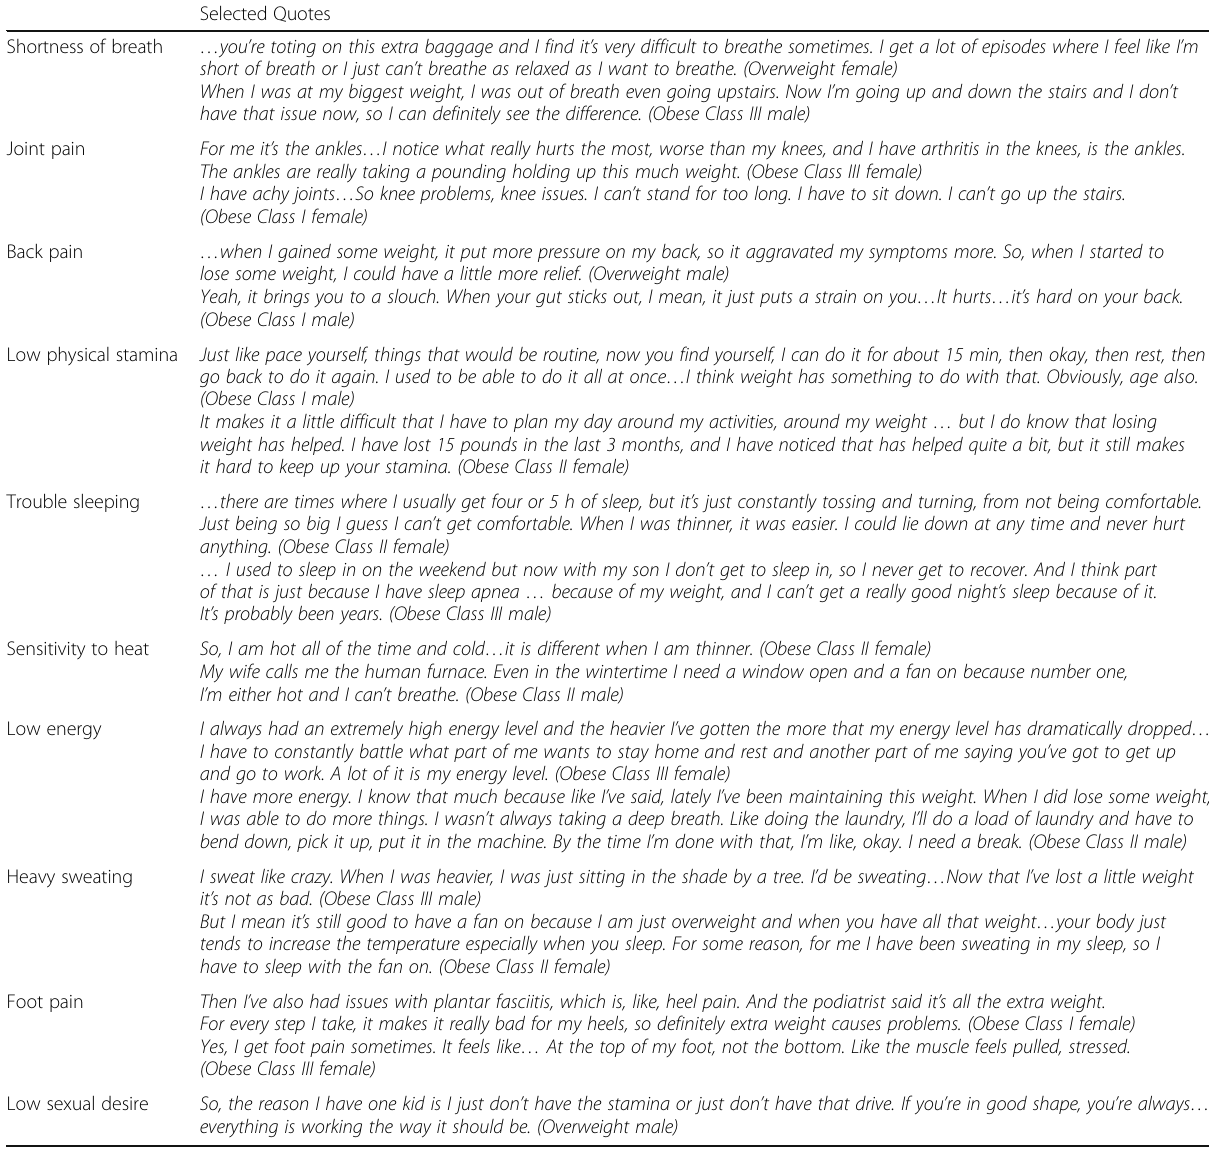
Table 4 Selected Quotes for Major Signs and Symptoms Selected Quotes Shortness of